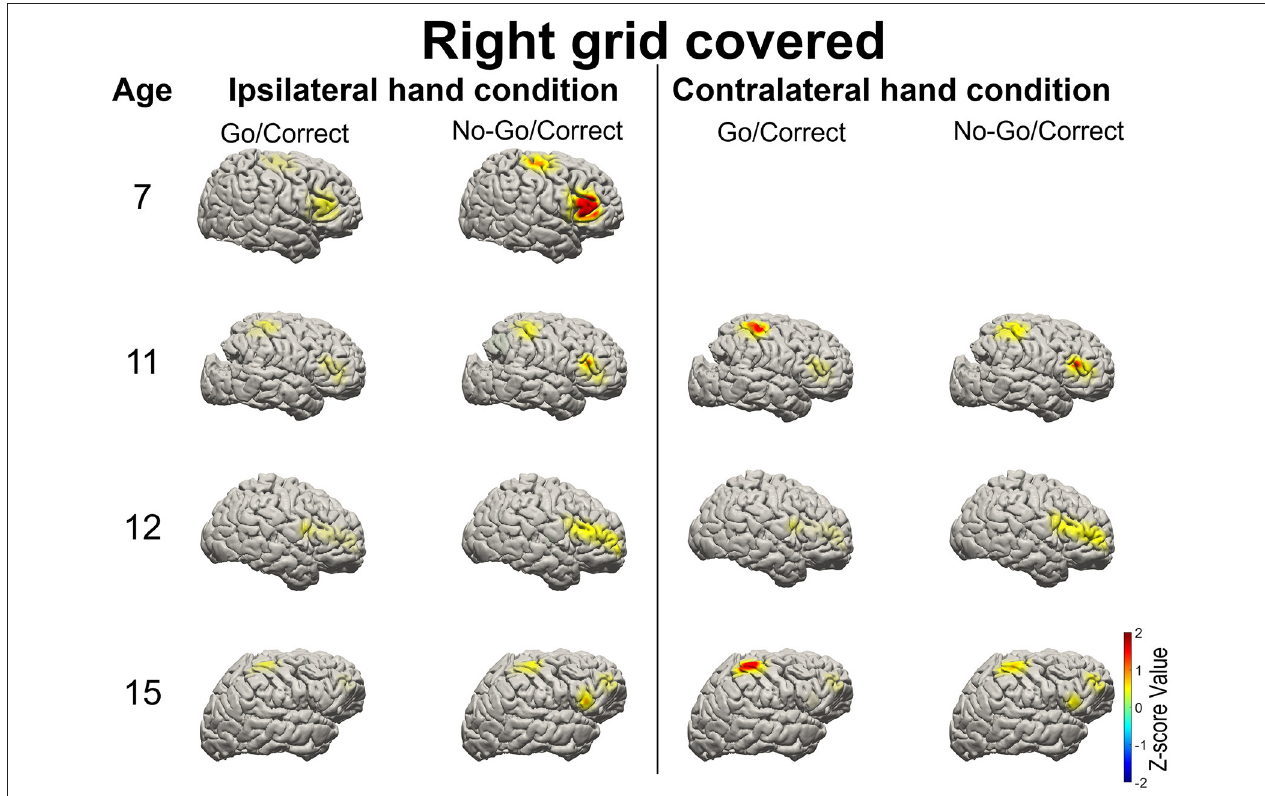
FIGURE 3 | Illustration of the mean high-gamma (HG) activation for the patients aged 7, 11, 12, and 15 years with right side grid coverage. Activation of the right IFG in No-Go/Correct trials is greater than that in Go/Correct trials. HG activation over the sensorimotor cortex was observed in Go/Correct trials when the contralateral hand was used (in this case the left